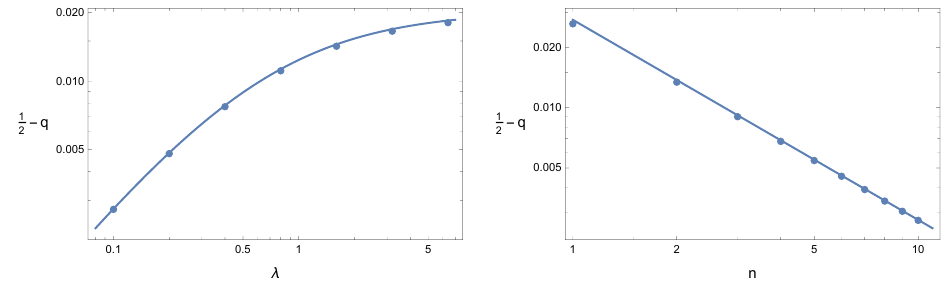
Figure 3 . The points are numerically determined values for q and the straight line is the (cid:12)rst order saddle point approximation in the (cid:12)xed (cid:21) , large n limit for (cid:11) = (cid:25) n = 10; (right) various values of n and (cid:21) = 0 :